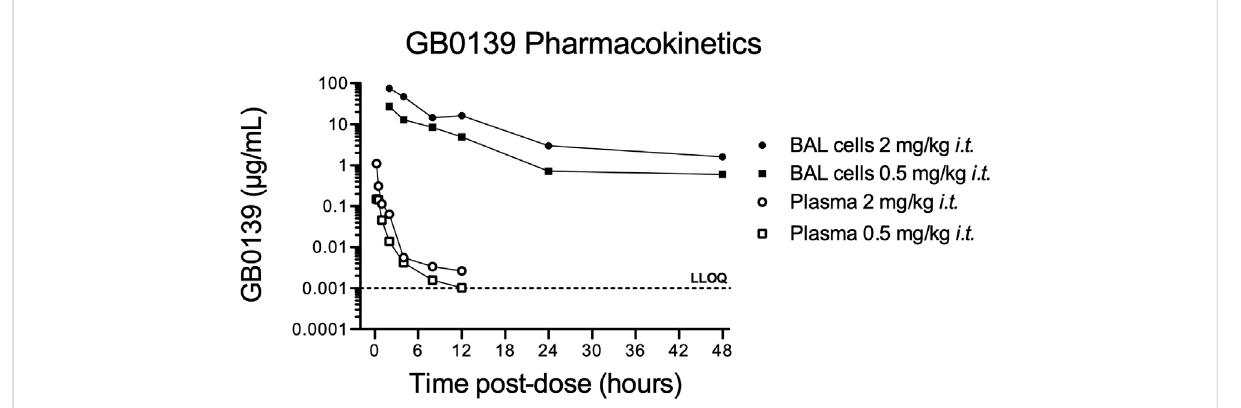
FIGURE 1 Pharmacokinetic pro fi le of GB0139 in female C57BL/6 mice following i.t. administration. BAL cell and total blood concentrations of GB0139 weredetermined byLC-MS/MSovertimefollowingsingle i.t. Administrationsof0.5 mg/kg and2 mg/kg.Datashown arethemeanvalues of three animals in each time point. BAL = broncho-alveolar lavage; i.t. = intra-tracheal; LC-MS/MS = liquid chromatography-tandem mass spectrometry; LLOQ = lowest level of quanti fi cation (1